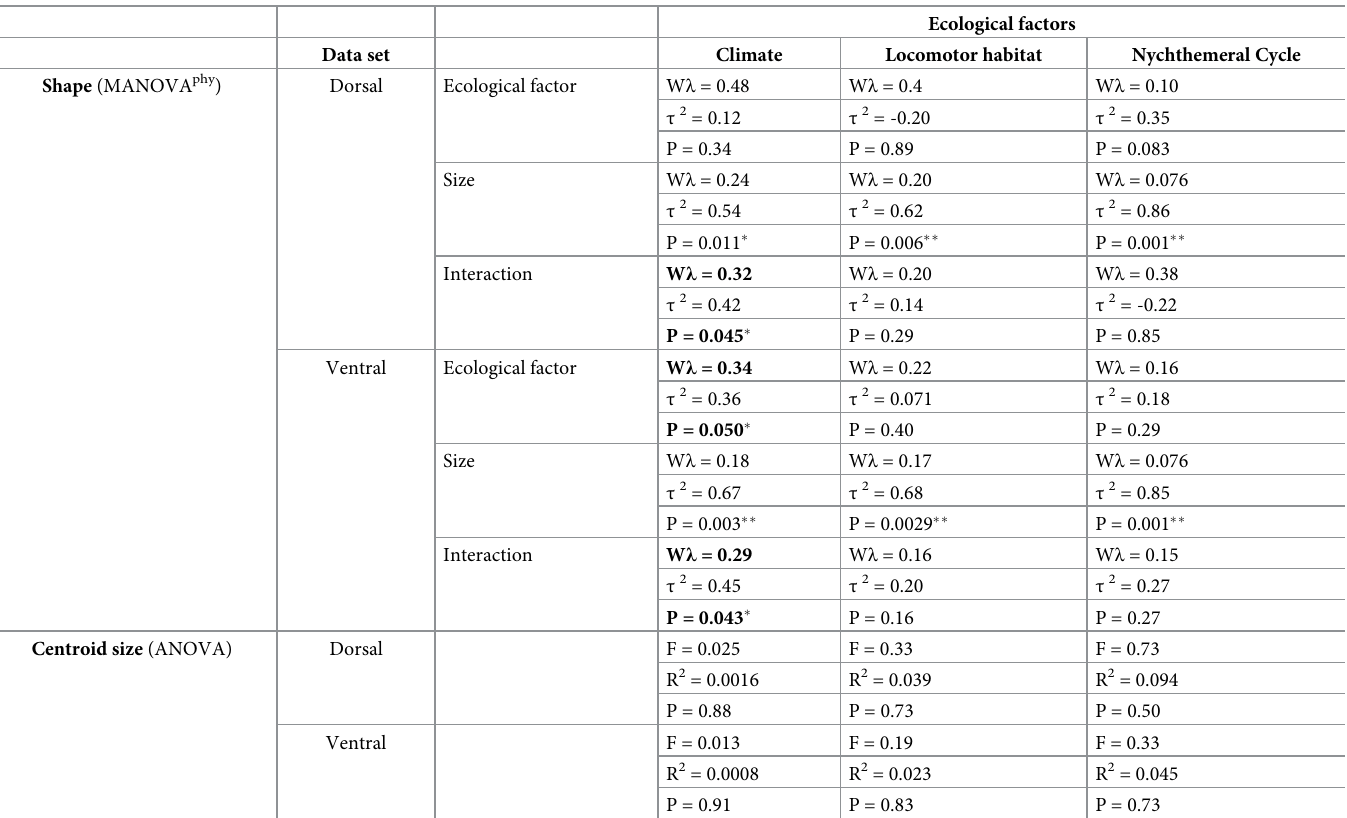
Table 4. Tests of ecological factors on shape and